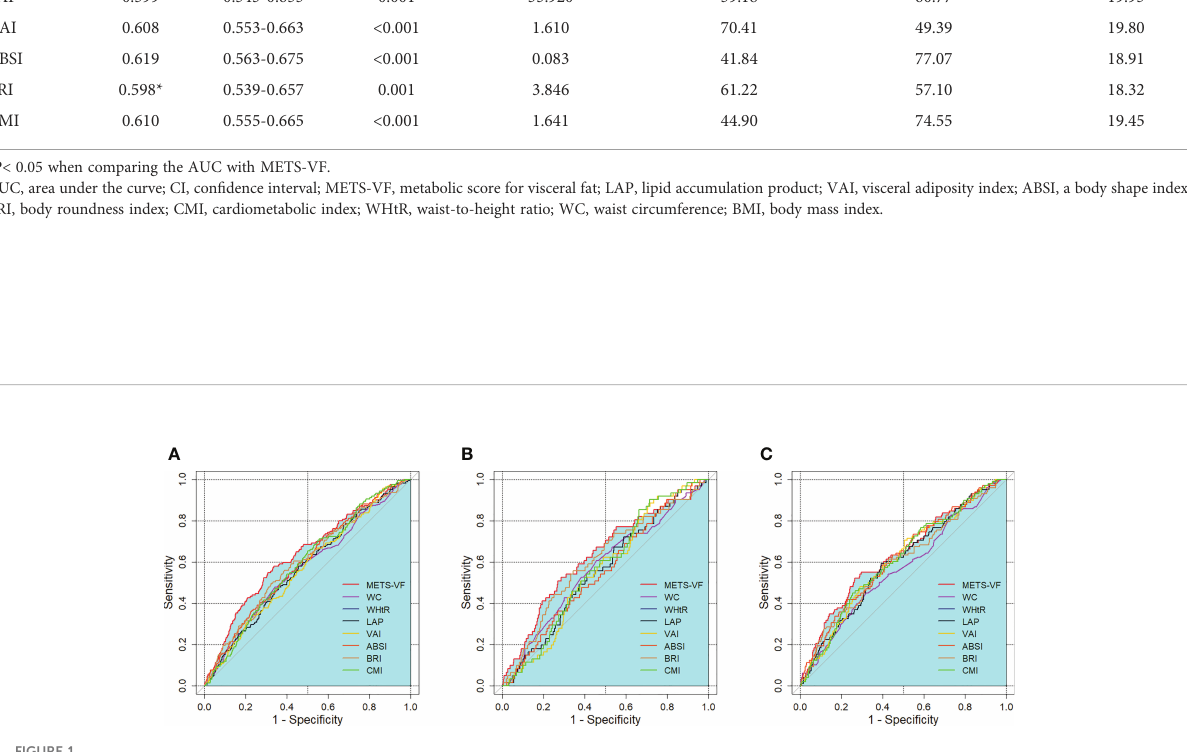
FIGURE 1 ROC curves for the prediction of CKD by adiposity indices. (A) total population, (B) men, (C) women. METS-VF, metabolic score for visceral fat; LAP, lipid accumulation product; VAI, visceral adiposity index; ABSI, a body shape index; BRI, body roundness index; CMI, cardiometabolic index; WHtR, waist-to-height ratio; WC, waist circumference; BMI, body mass index.